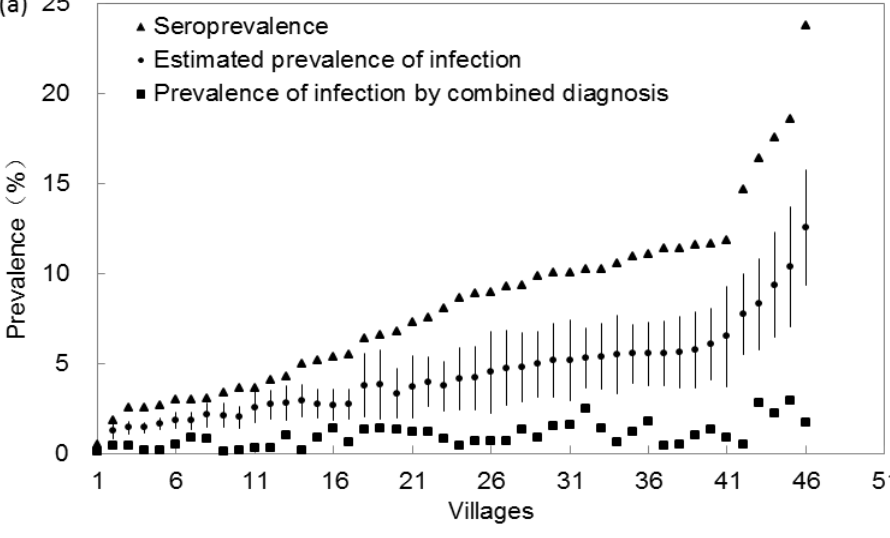
Figure 2. Estimated prevalence of infection for each village in the survey of S. japonica in Hubei Province, China, 2011. ( a ) Prevalence of infection was estimated using data from IHA test and Kato-Katz test. (Situation 1). ( b ) Prevalence of infection was estimated using data from the IHA test alone (Situation 2). Villages were ordered by ascending